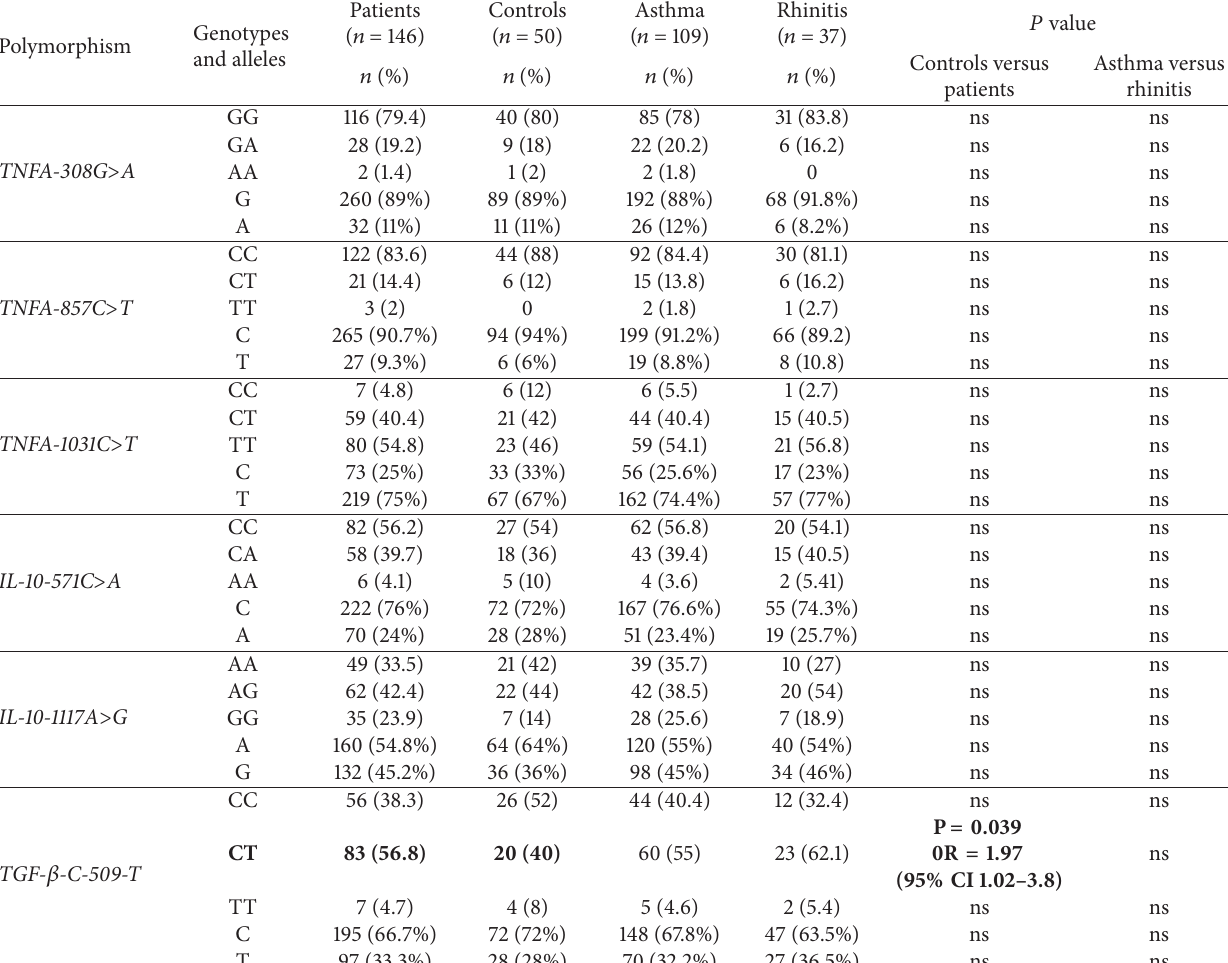
Table 3: TNF- 𝛼 , IL-10, and TGF- 𝛽 genotype and allele